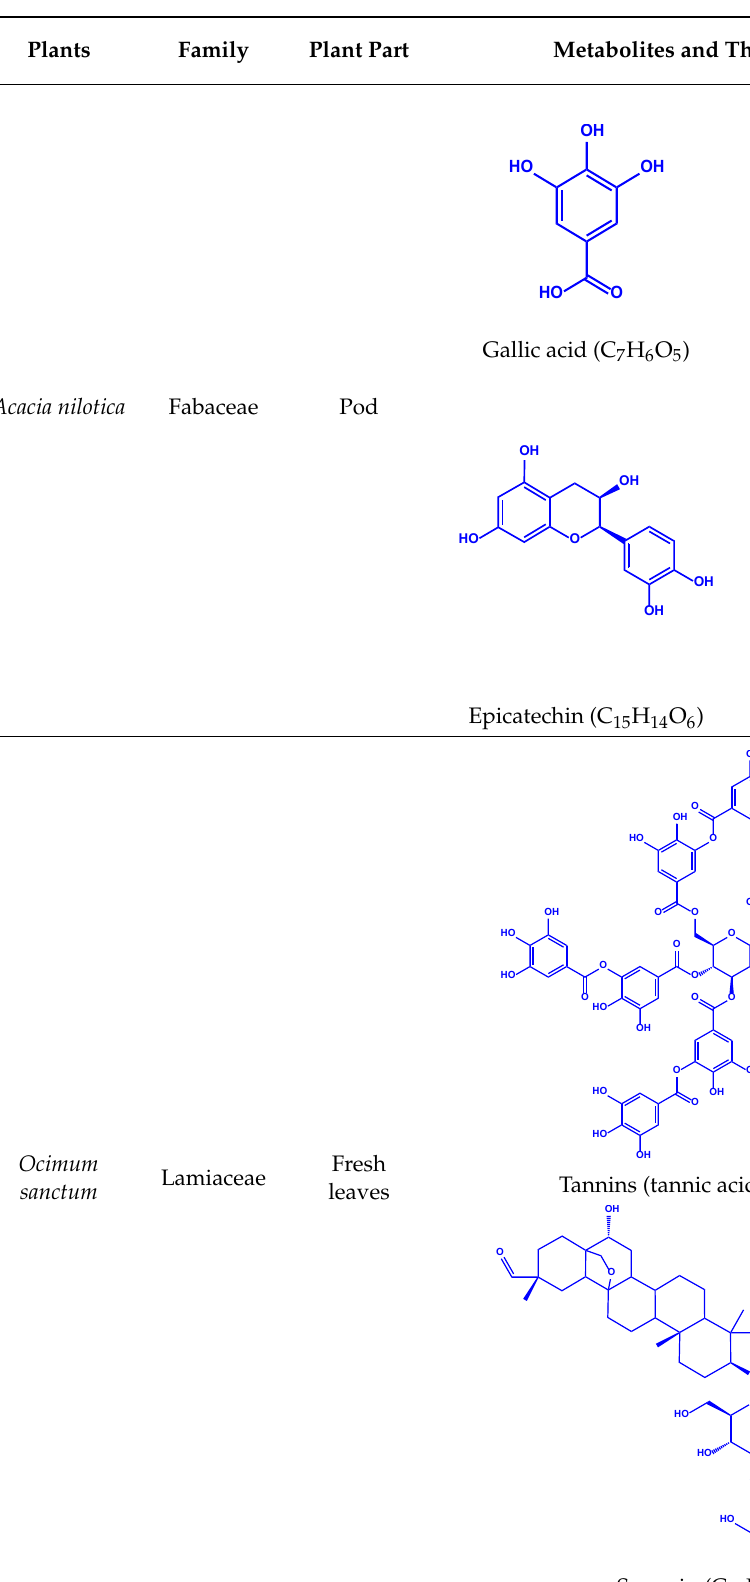
Table 1. Biological synthesis of AgNPs from various plant species.